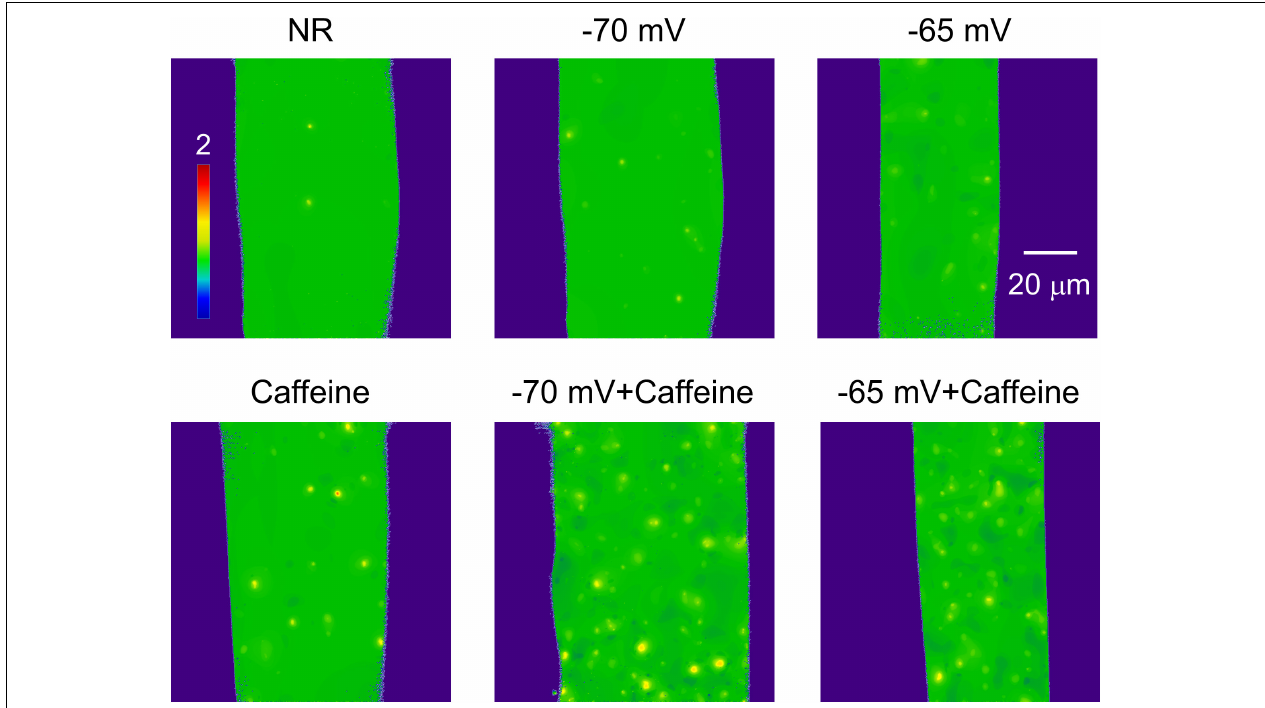
FIGURE 3 | Normalized (F/F 0 ) full size x-y images of intact frog skeletal muscle fibers bathed in Normal Ringer (NR), in the presence of 1 mM Caffeine (Caffeine), in depolarizing solutions corresponding to a calculated resting membrane potential of -70 and -65 mV, and supplemented with 1 mM Caffeine. All images were recorded with 30 FPS. Note how the number of sparks is changing with the different conditions.